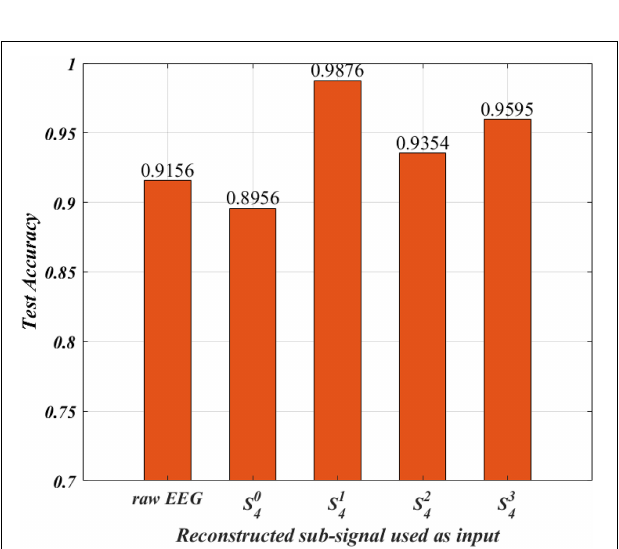
FIGURE 3 | The architecture of the proposed DRes-CNN.